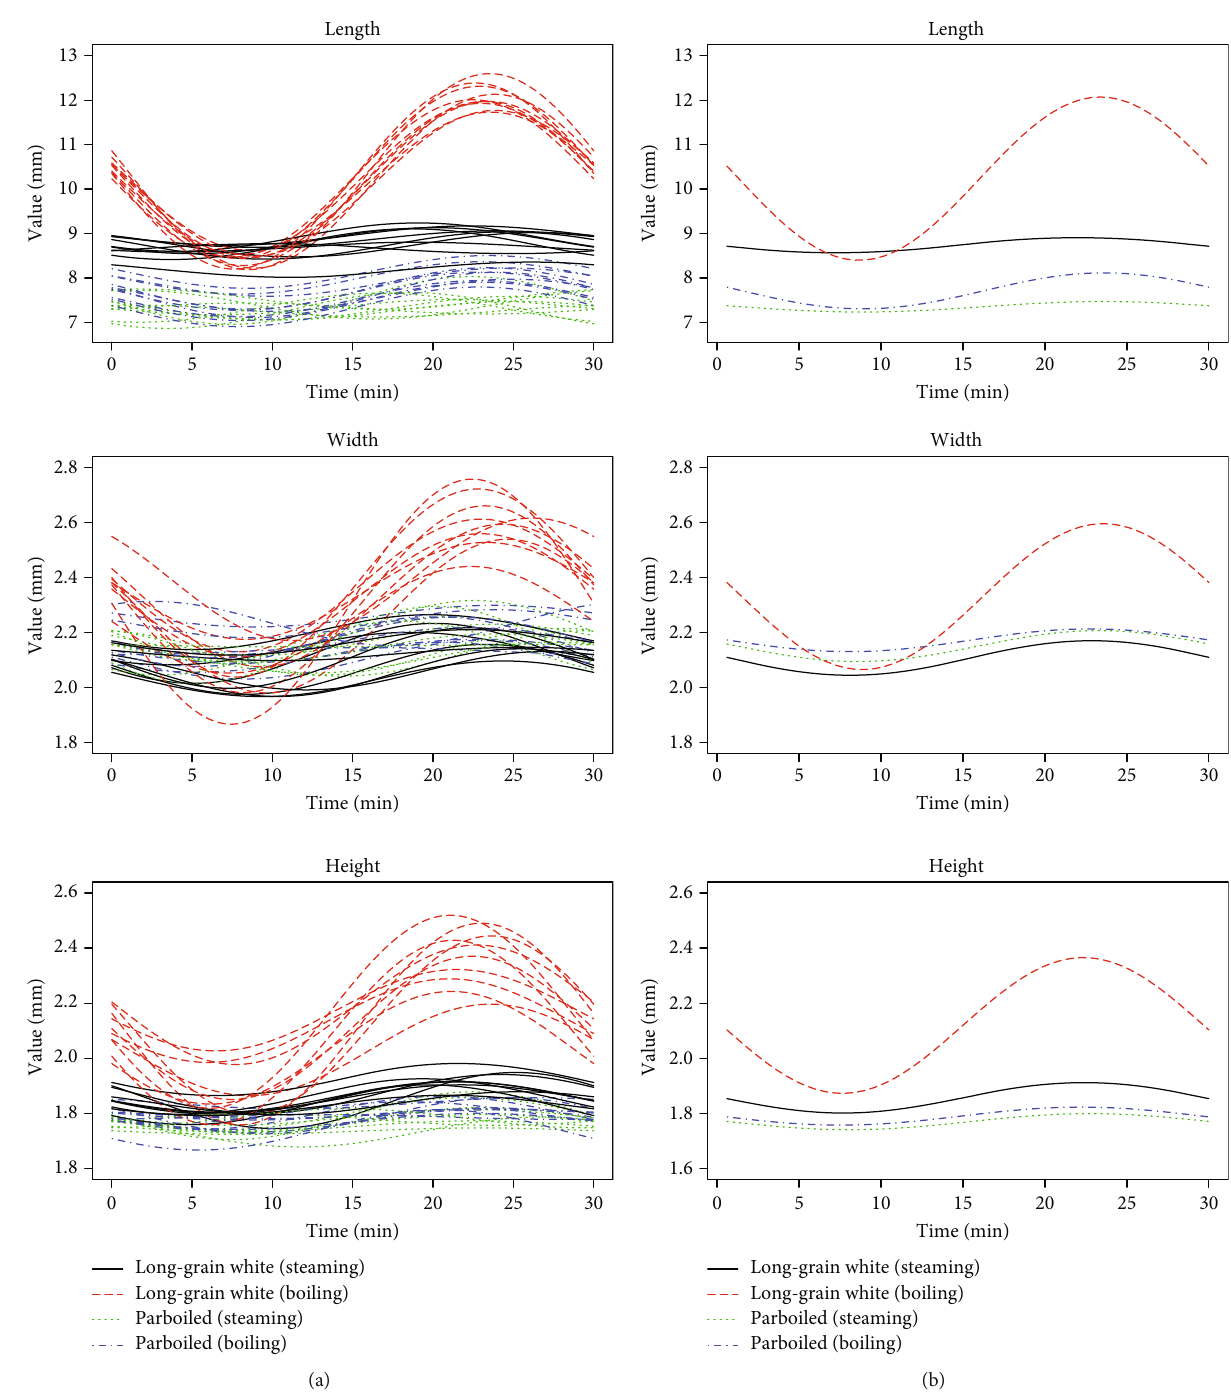
Figure 3: Trajectories of functional data (a) and sample mean functions (b) shown separately for each